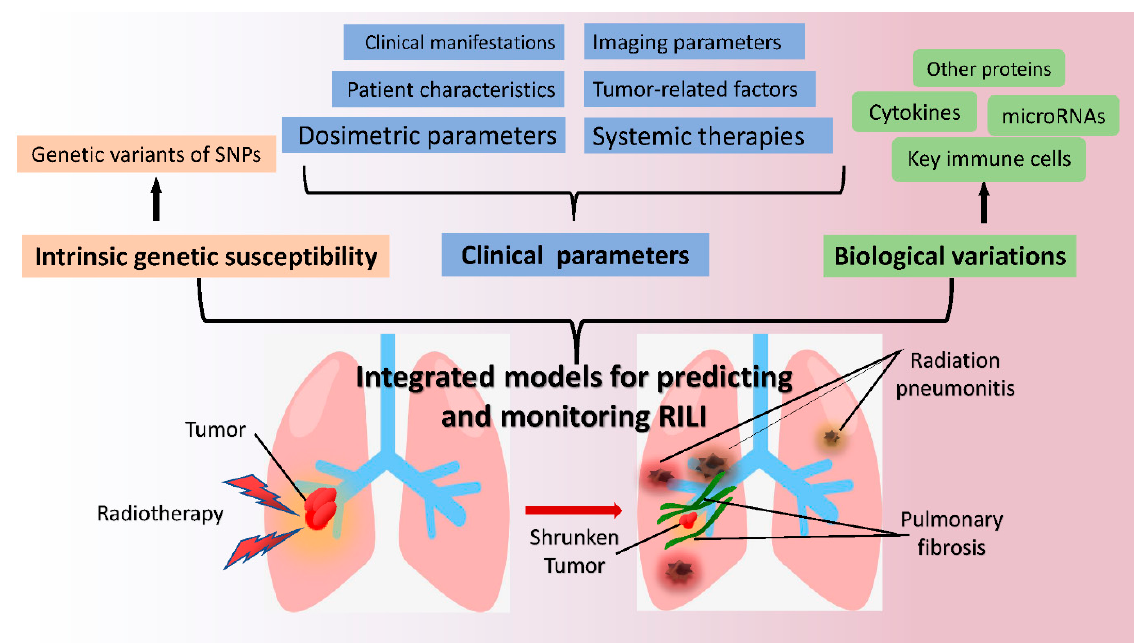
Figure 2. Illustration of the integrated model for predicting and monitoring RILI.